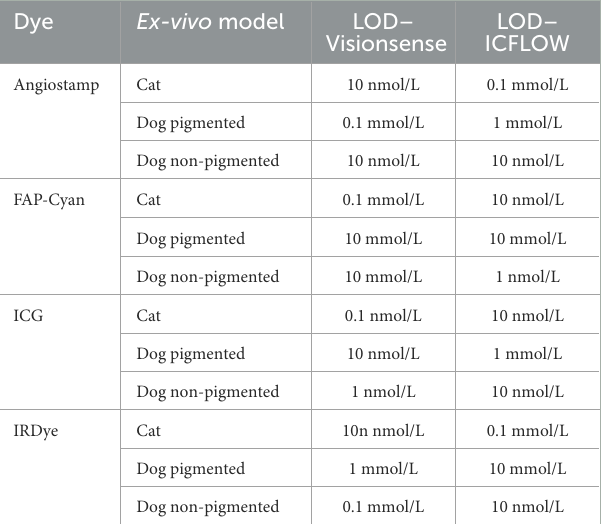
TABLE 1 Limit of detection (LOD) recorded for each dye, tested in each ex-vivo model with the two camera